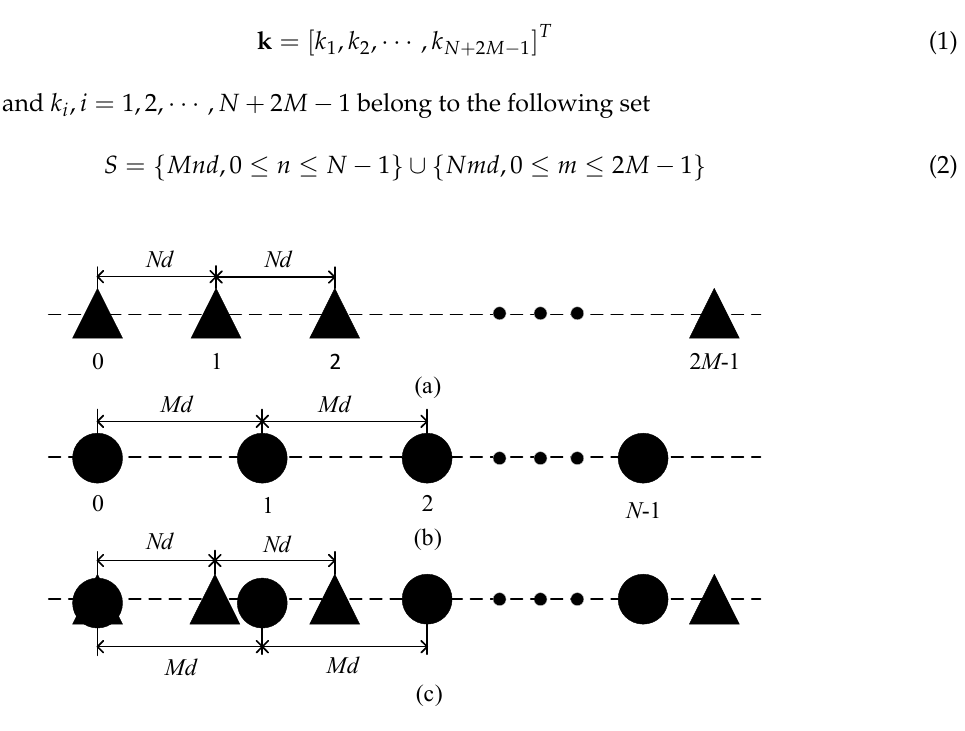
Figure 1. Illustration of coprime array configuration: ( a ) the first subarray; ( b ) the second subarray; ( c ) the generated coprime array.